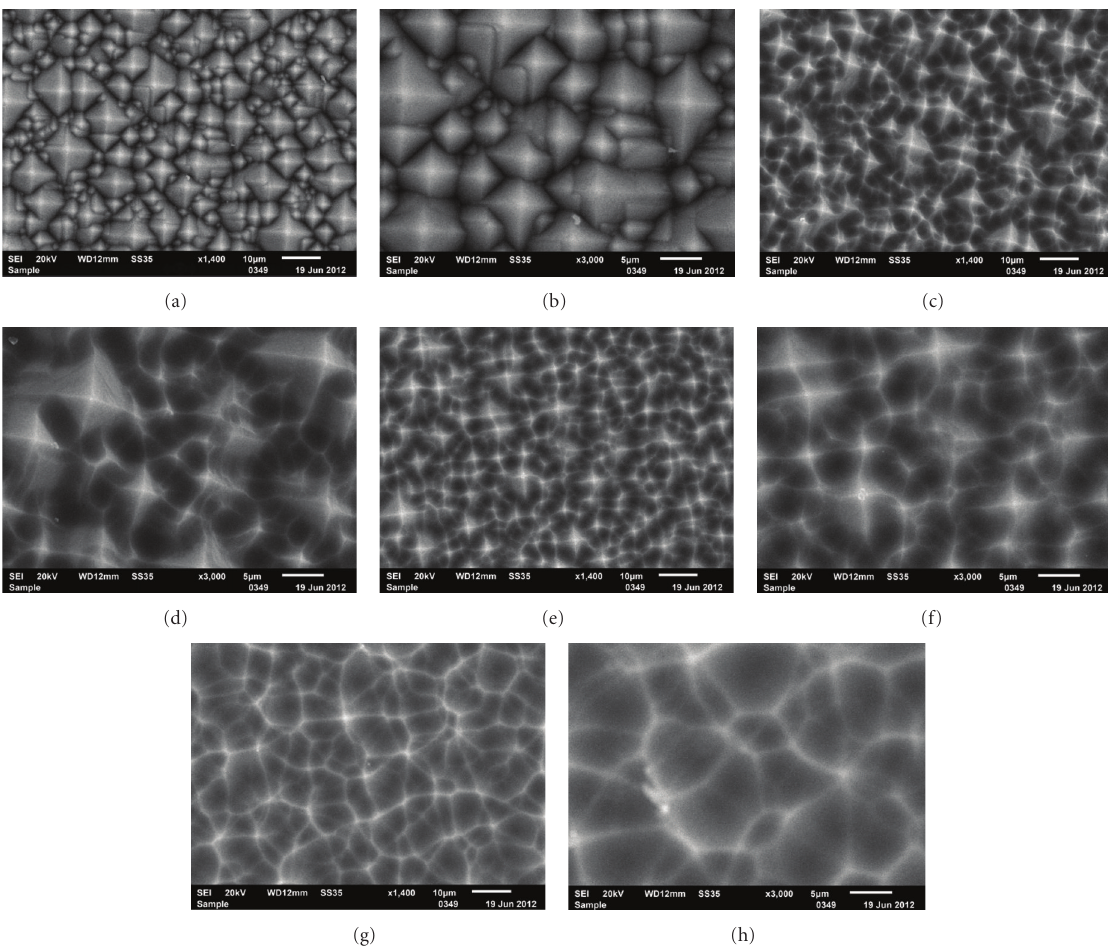
Figure 3: SEMs of pyramids topology: (a) 1400x and (b) 3000x process without backside rounding process. (c) 1400x and (d) 3000x process with backside rounding of ED3. (e) 1400x and (f) 3000x process with backside rounding of ED6. (g) 1400x and (h) 3000x process with backside rounding of ED9.